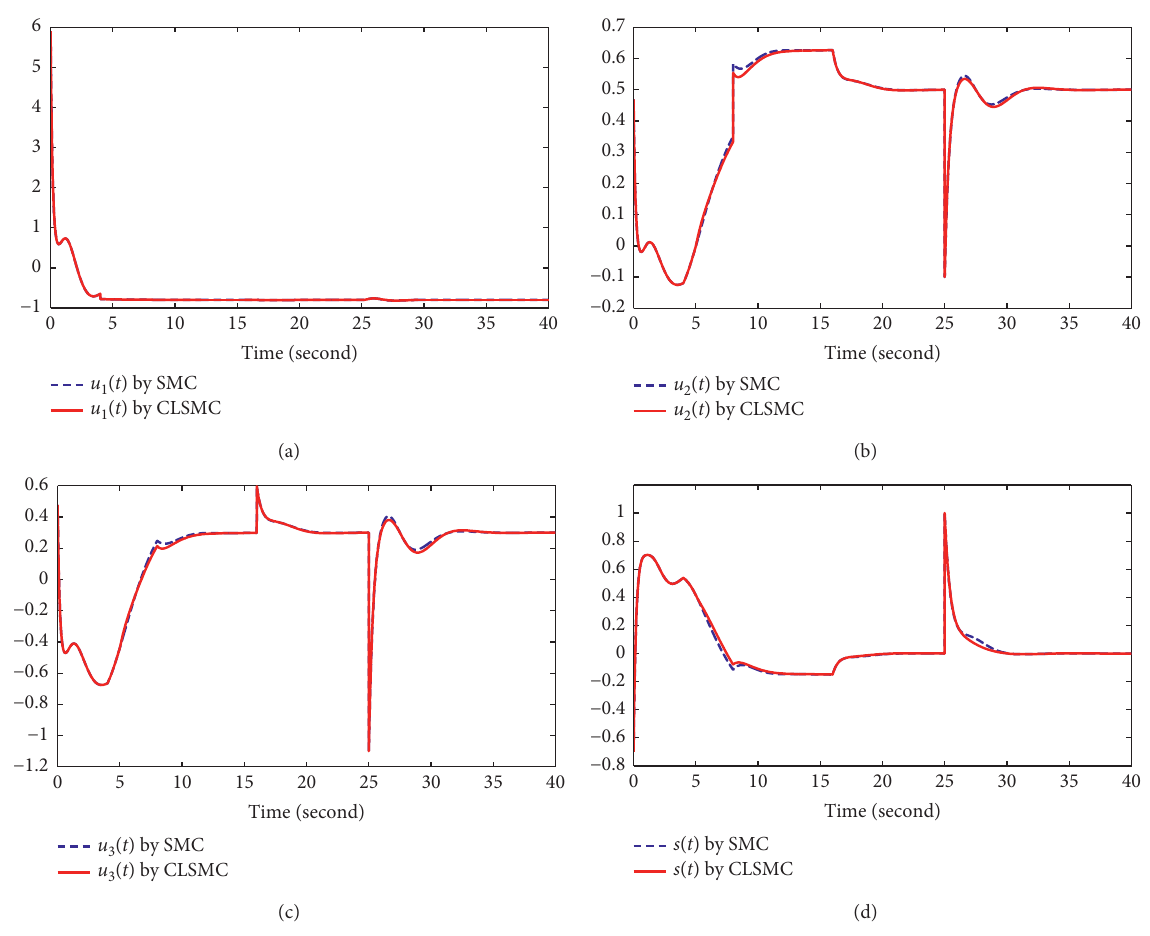
Figure 2: Control inputs and sliding surface of SMC and